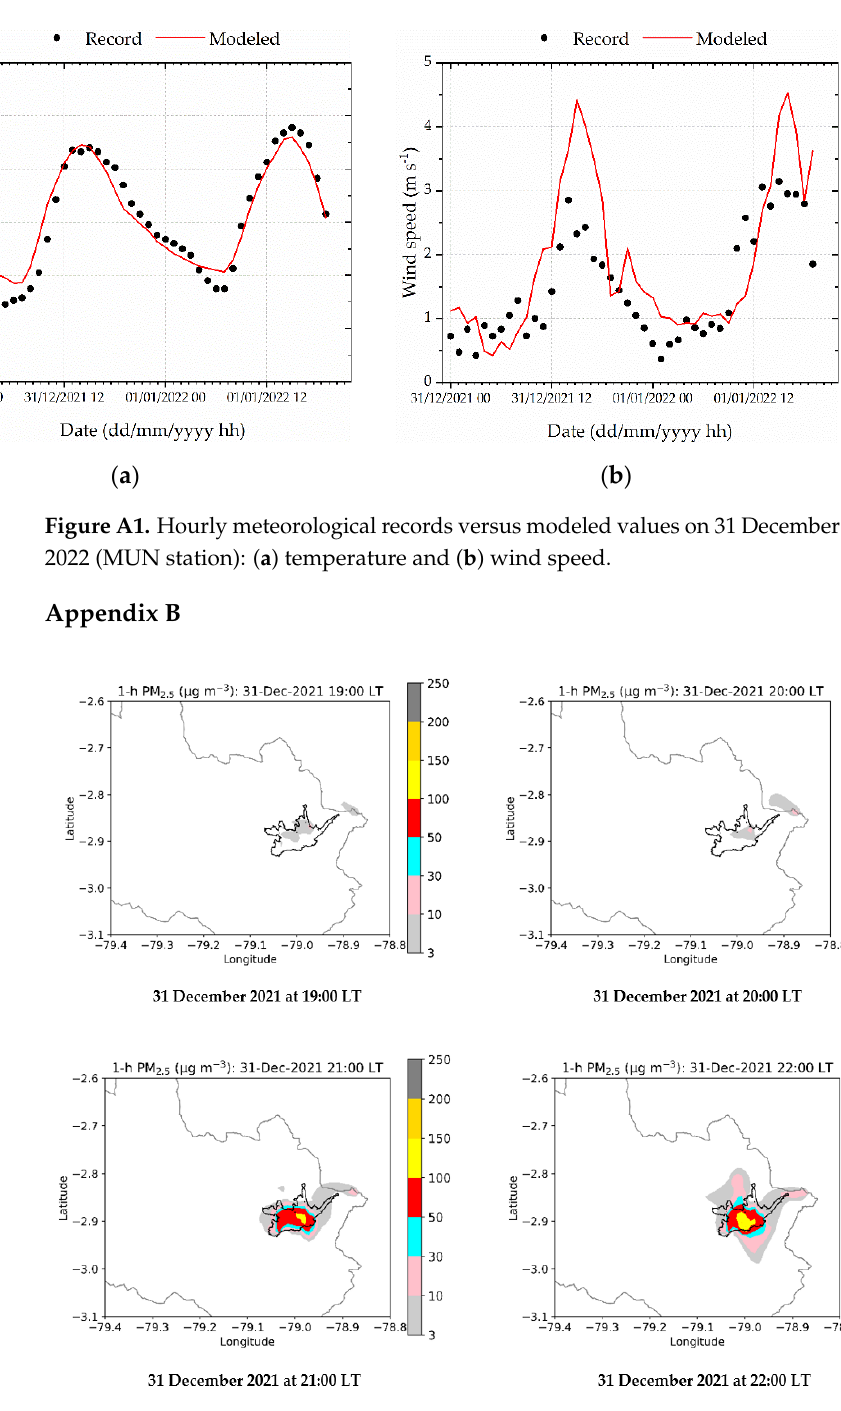
Figure A2. Modeled maps of hourly PM 2.5 concentrations from 31 December 2021 at 19:00 LT to 1 January 2022 at 00:00 LT. Scenario assuming that New Year’s emissions began on 31 December 20221 at 21:00 LT.